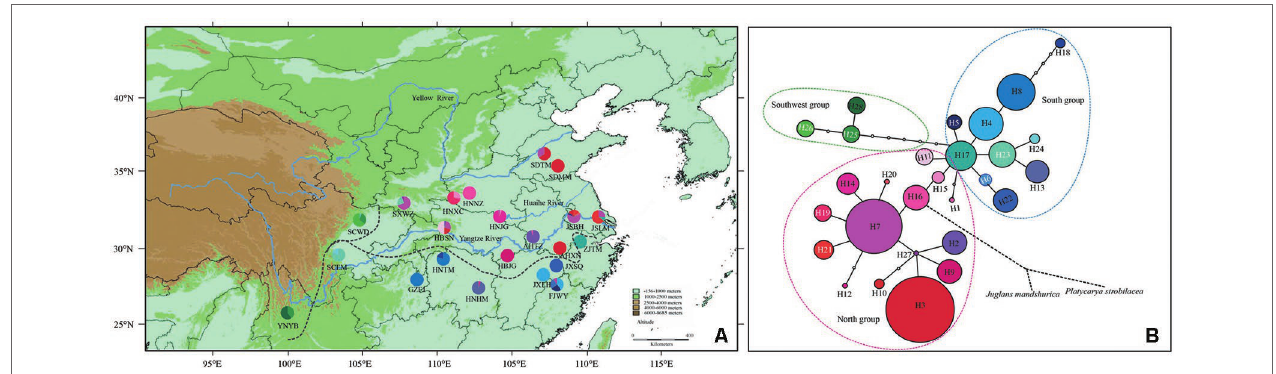
FIGURe 1 | Geographic distribution and genealogical relationships of chloroplast DNA (cpDNA) haplotypes recovered from Pterocarya stenoptera populations in China. (A) Sampling localities of 22 populations of P. stenoptera and the geographic distribution of 28 haplotypes (H1–H28) detected (for population codes see Table 1 ). The dotted line represents the dividing line of three genetic groups that identified by cpDNA data. (B) The statistical parsimony network of haplotypes H1–H28. The size of circles corresponds to the frequency of each haplotype. Each solid line represents one mutational step interconnecting two haplotypes for which parsimony is supported at the 95% level, the black dotted line represents multiple mutational steps that connected with outgroups. The colorful dotted line represents the dividing line of three genetic groups that identified by cpDNA